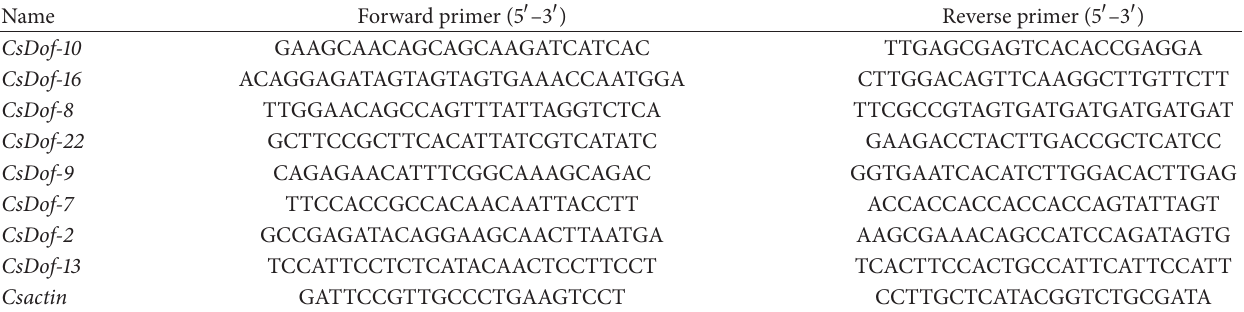
Table 1: Primer sequences of the Dof genes in C. sinensis for qRT-PCR.